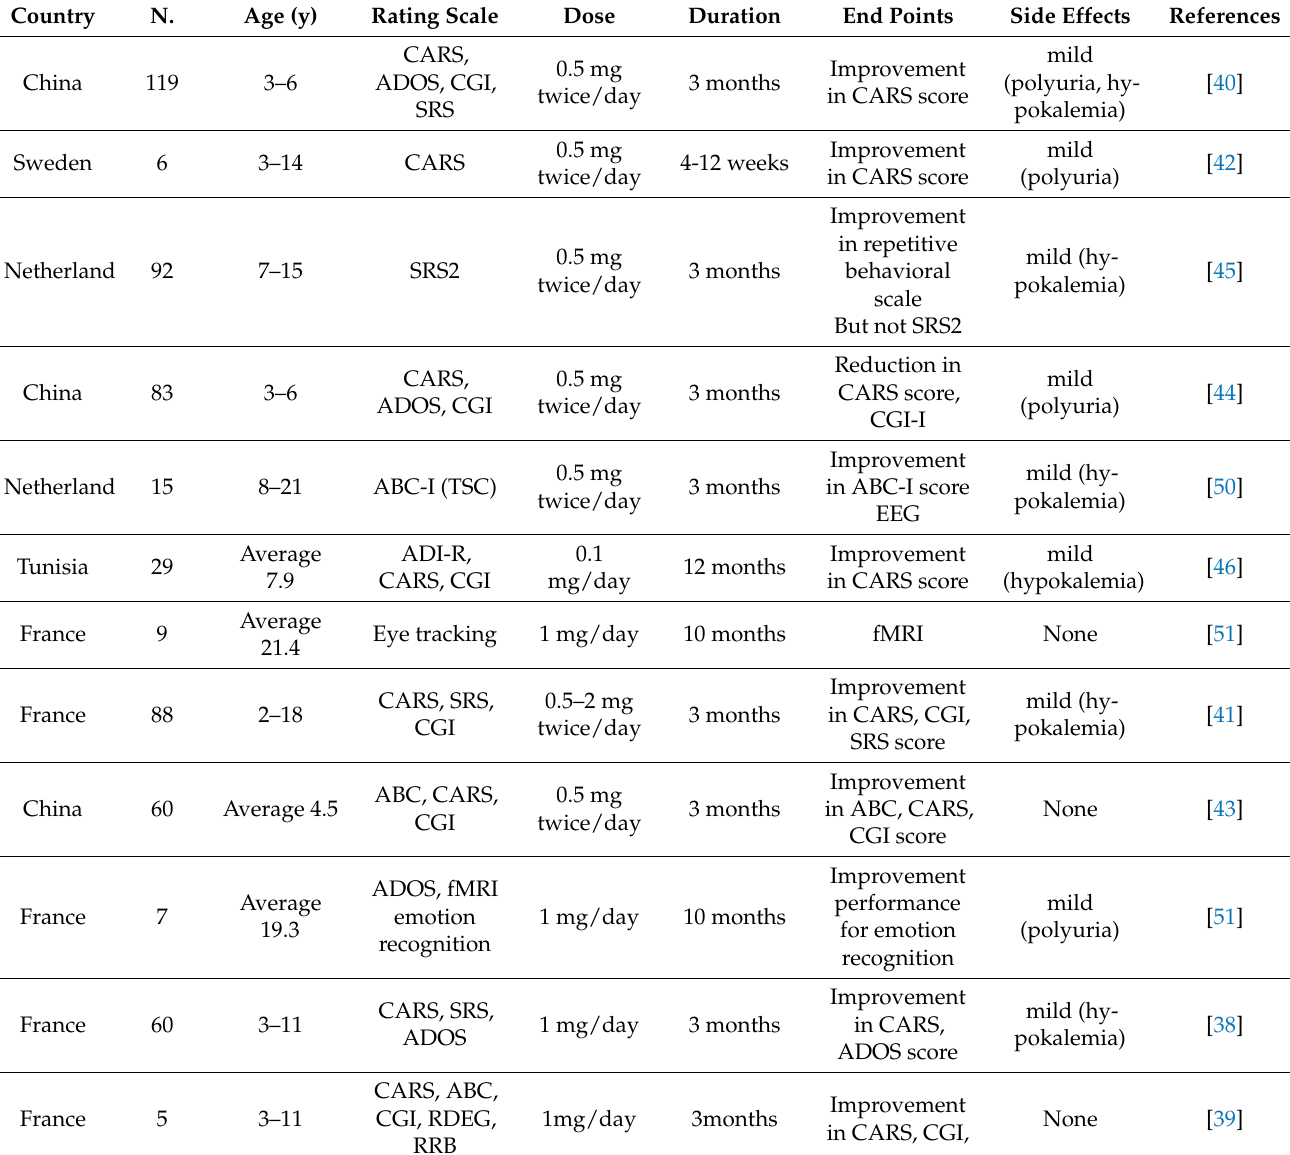
Table 1. Summary of the clinical trials using bumetanide to treat ASDs. Positive effects were observed in pilot or double-blind, randomized trials performed in France, China, Sweden, Great Britain, The Netherlands, and Tunisia. Two open trials evaluated eye-tracking and fMRI changes with